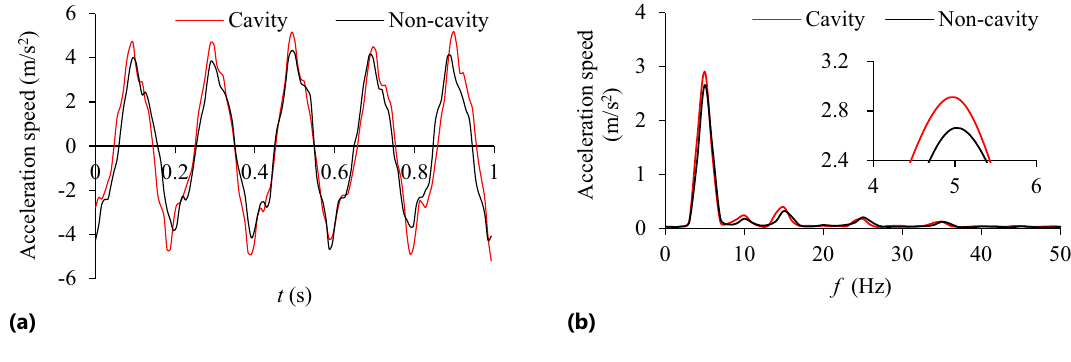
Figure 14. Acceleration speed of system n = 90 r/min: (a) Time-domain; (b) Frequency domain.